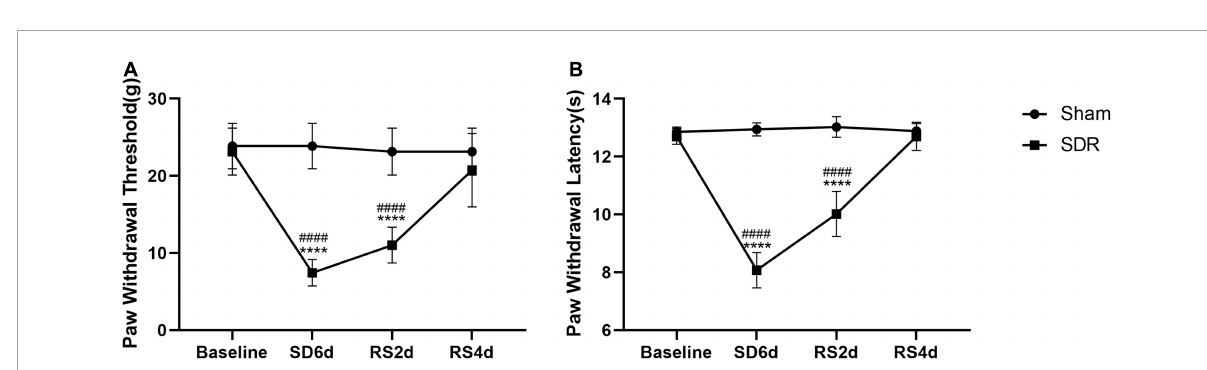
FIGURE4 Paw withdrawal threshold (A) and paw withdrawal latency (B) in rats. Rats 1–8 in the Sham group and 1–8 in the SDR group. The PWT and PWL of rats decreased significantly after 6 days of SD, and the PWL recovered after 2 days of RS compared to 6 days of SD, and both PWT and PWL returned to baseline levels after 4 days of RS. **** P < 0.0001 compared to the sham group. #### P < 0.0001 compared with baseline and RS4d in the SDR